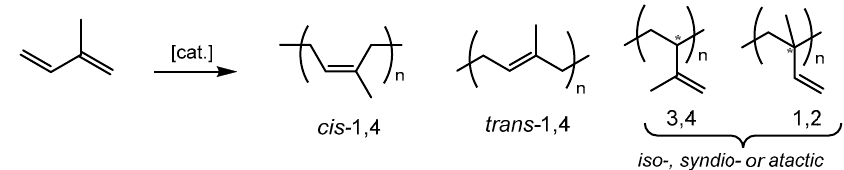
Figure 1. Microstructure contents of polyisoprene.